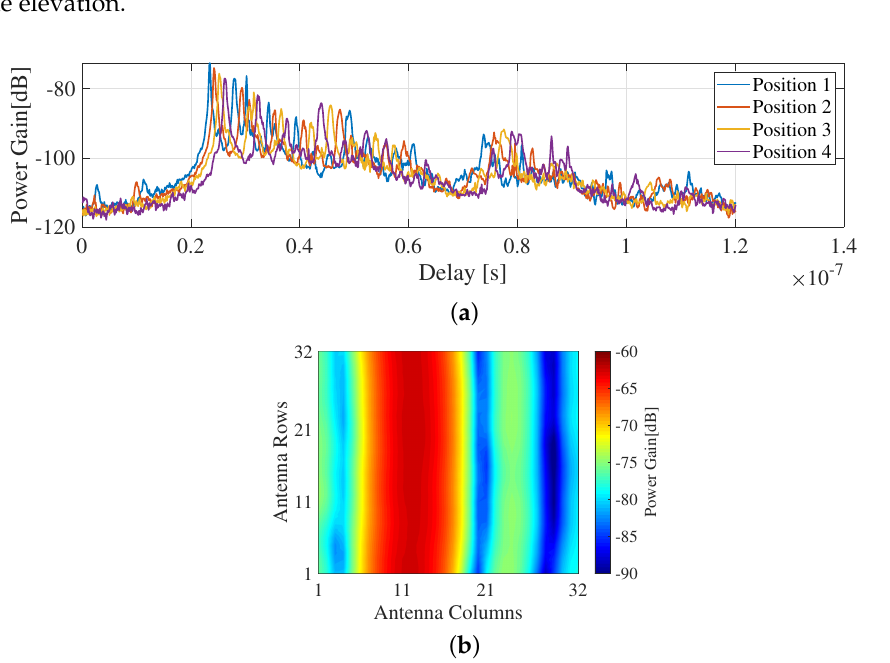
Figure 3. PDP of the channel observed in an indoor classroom scenario. ( a ) Power distribution in different delays at 4 locations. ( b ) Power distribution in spatial domain for one LoS path at Position